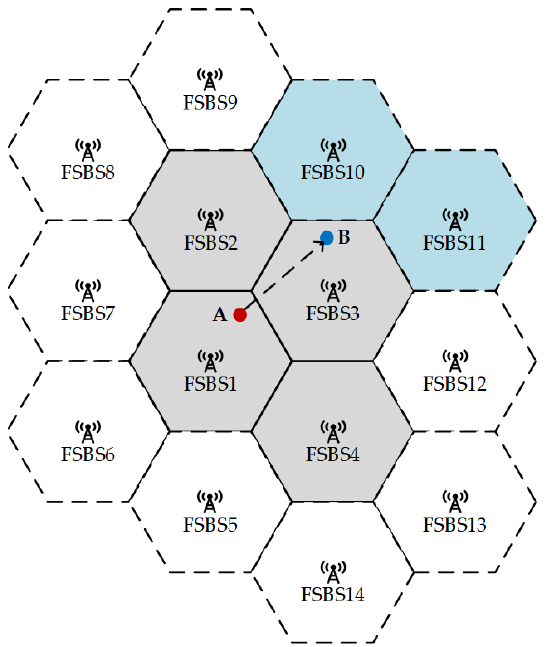
Figure 7. Schematic diagram of adjacent FSBS.